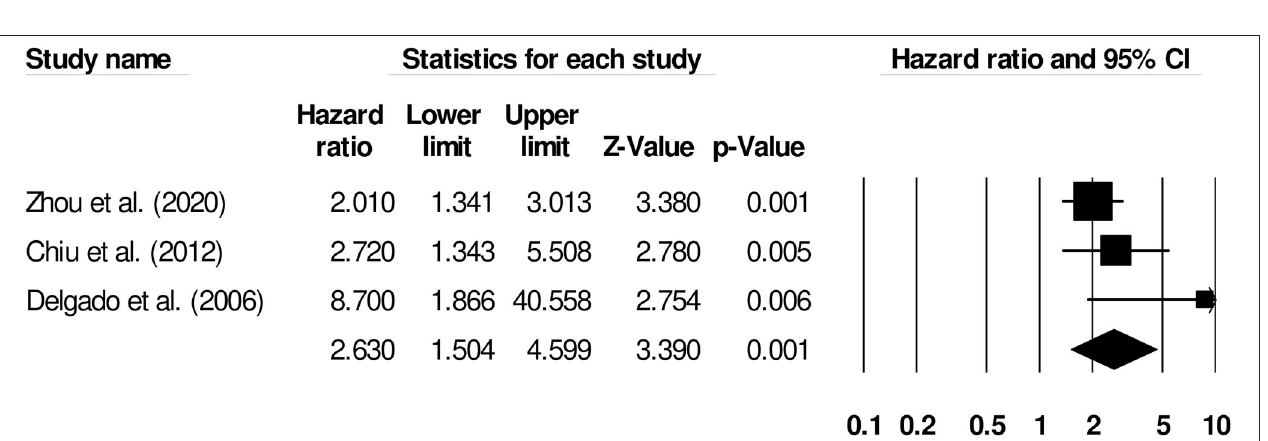
FIGURE 11 | Forest plot for studies evaluating the impact of D-dimer level on post-intracerebral hemorrhage mortality outcomes. Hazard ratios are presented as black boxes while 95% confidence intervals are presented as whiskers. A small hazard ratio represents a lower influence of D-dimer levels on stroke patient functional outcome while a higher hazard ratio represents a higher influence.